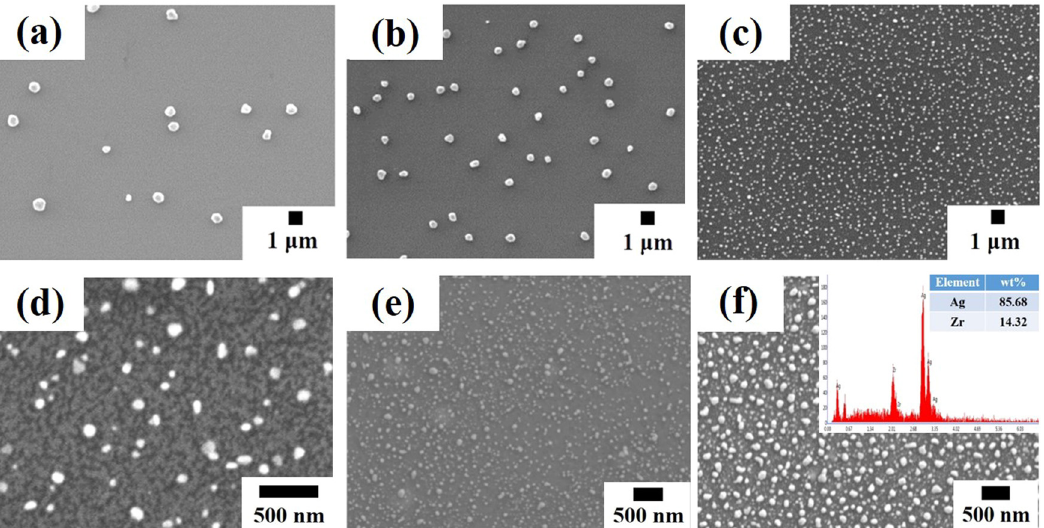
Figure 4: Surface morphology of Ag – Zr alloy fi lms on di ff erent substrates by composite target sputtering after annealing at 260°C: ( a ) glass substrate, ( b ) Si substrate and ( c ) PI substrate. Surface morphology of Ag – Zr alloy fi lms on di ff erent substrates by co - sputtering: ( d ) glass substrate, ( e ) Si substrate and ( f ) PI